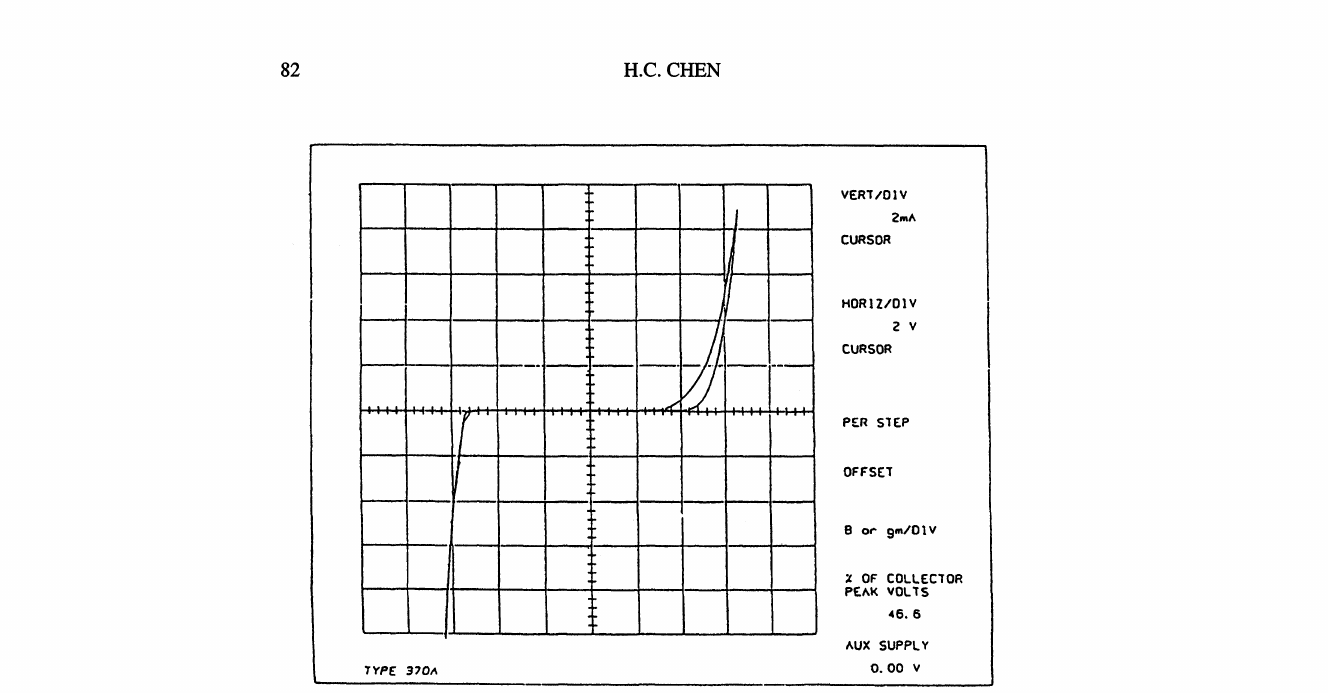
FIGURE 2 Isu/:, versus Vsu/: with source (or drain) grounded. Both polarities are shown the formation of a positive feedback loop that makes the device